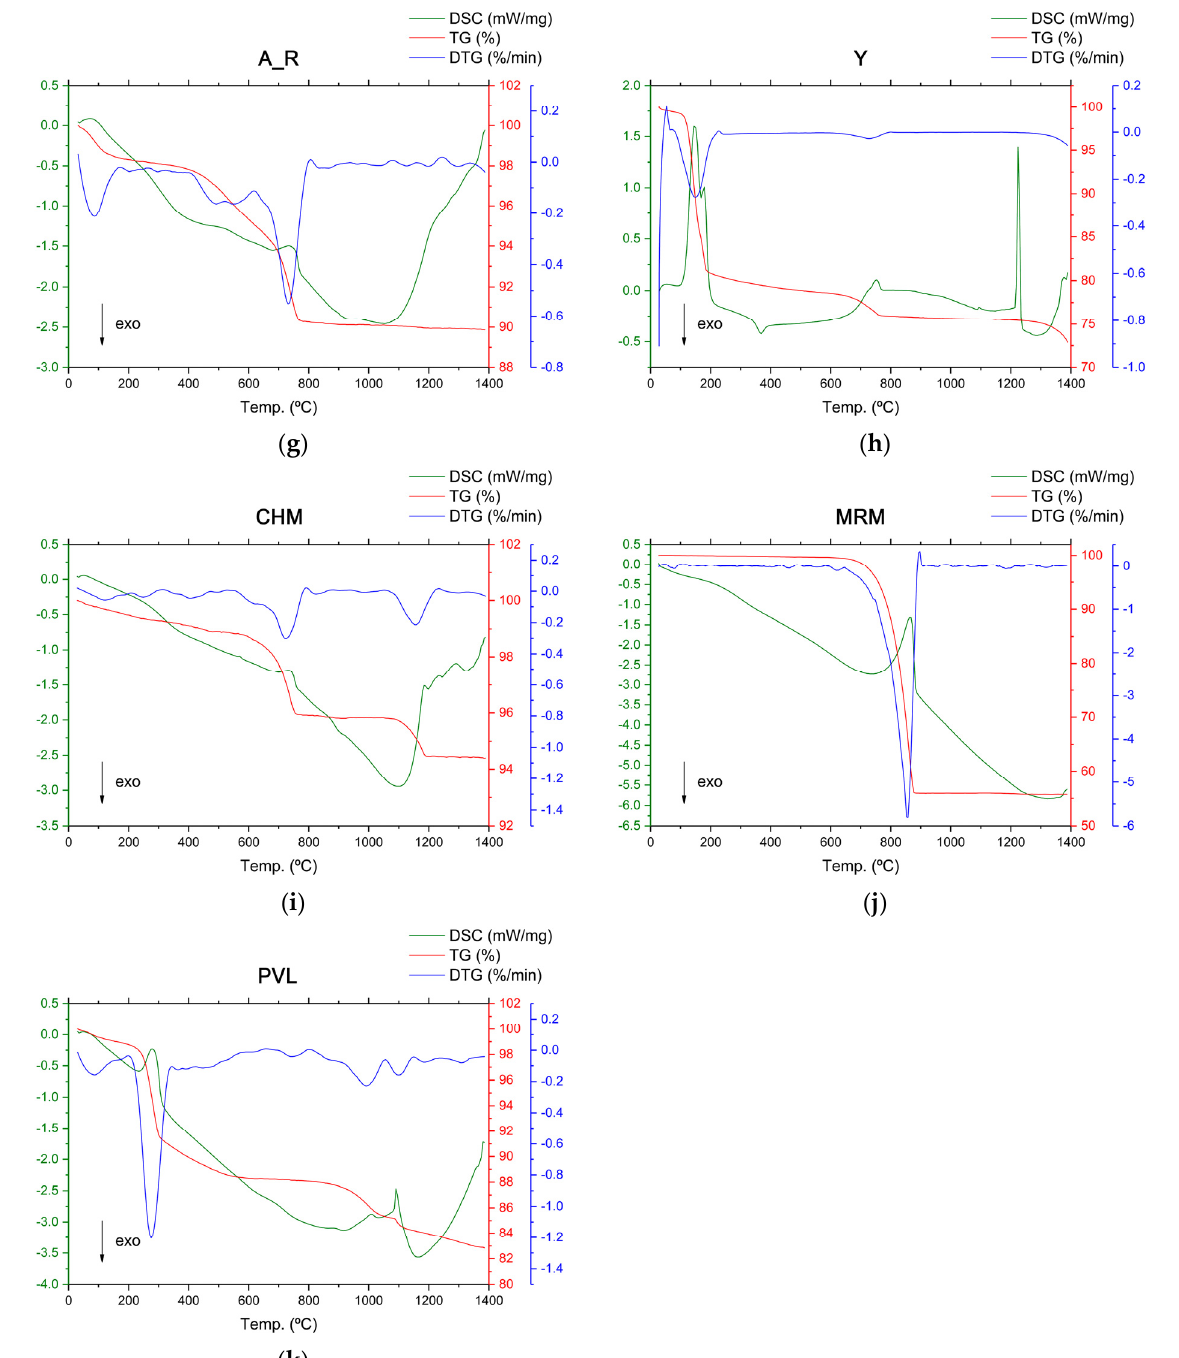
Figure 4. TG (red line), DTG (blue line), and DSC (green line) analysis of: ( a ) C_A; ( b ) C_SN_1; ( c ) C_SN_2; ( d ) C_T; ( e ) A_A; ( f ) A_N; ( g ) A_R; ( h ) Y; ( i ) CHM; ( j ) MRM; ( k ) PVL.